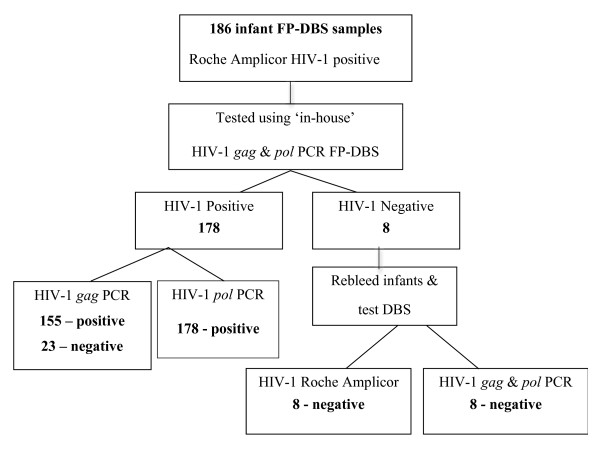
Experimental approach for performance of HIV-1 gag and pol FP-DBS PCR assay for detection of HIV-1 infection from FP-DBS obtained from HIV-1 positive infants as defined by Roche Amplicor v1.5 assay. 186 recently collected FP-DBS that were determined in the prior ~month to be HIV-1 positive by Roche Amplicor v1.5 assay were tested by HIV-1 gag and pol PCR assays. Of these 178 FP-DBS from the infants were identified as HIV-1 positive. Retesting of subsequent blood samples from the 8 discordant infants showed that they were HIV-1 negative. Thus, the sensitivity of HIV-1 pol PCR assay was found to be 100% (178 of 178) for detection of confirmed HIV-1 positive infants from FP-DBS.